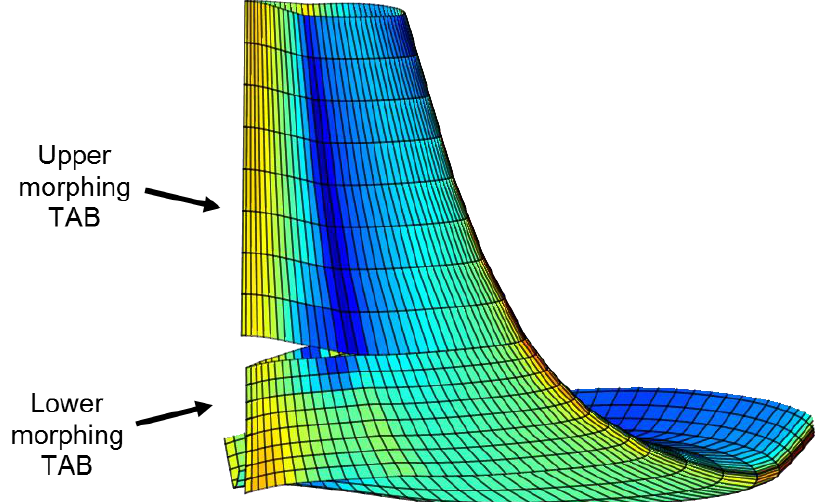
Figure 1. Morphing winglet concept with upper and lower control surfaces.